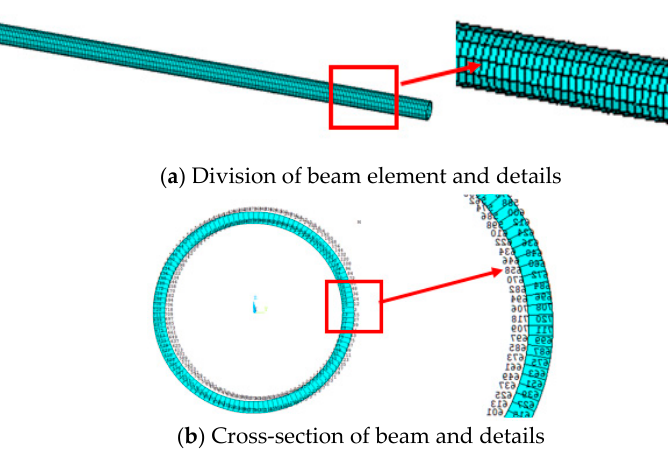
Figure 6. Finite element model of beam and its cross-section division.